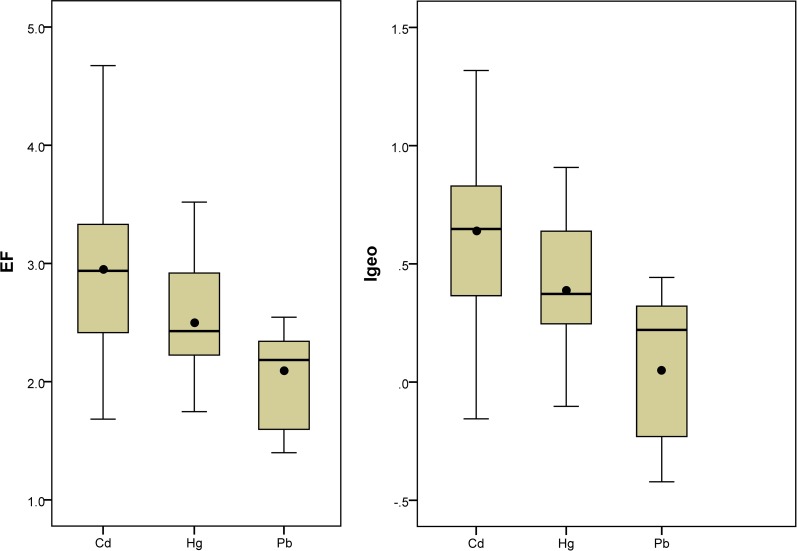
Sediment core trace metal EF and Igeo results from the Beidagang Wetland Nature Reserve.The box extends from the lower quartile (25%) to the upper quartile (75%), covering the median (line) and the mean (black point) values; Vertical bars represent the error.